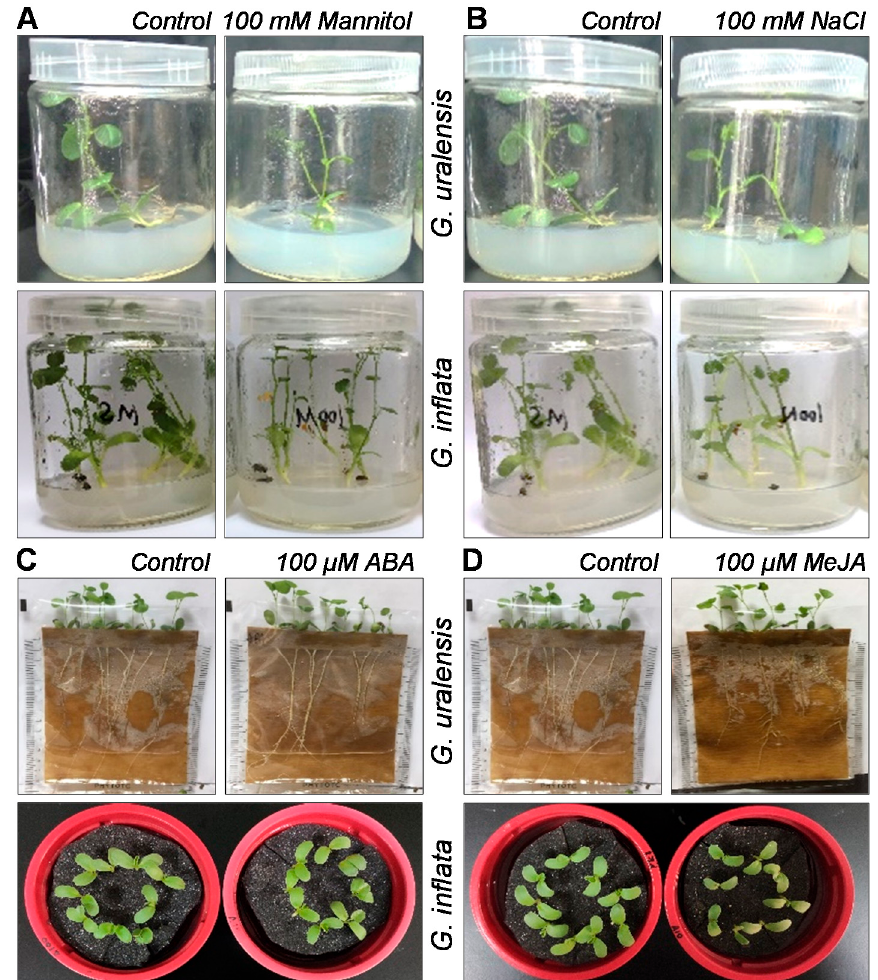
Figure 8. The morphology of G. uralensis and G. inflata under different experimental conditions: the morphology of G. uralensis and G. inflata under osmotic stresses ( A ), salt stresses ( B ), Abscisic acid (ABA) treatment ( C ), and methyl jasmonic acid (MeJA) treatment ( D ). Photos were taken 4 weeks after osmotic and salt treatments and 6 h after ABA or MeJA treatments.